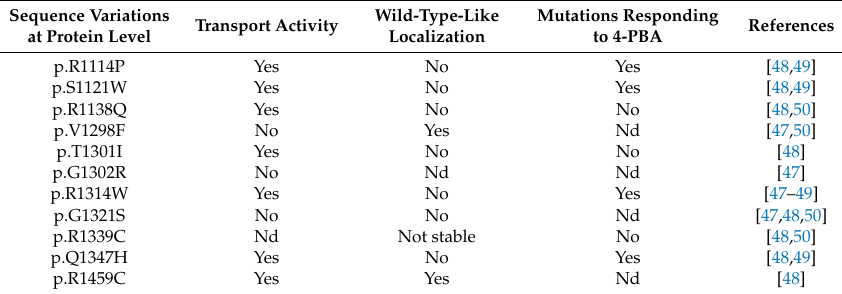
Table 1. Summary of PXE-associated ABCC6 mutations.